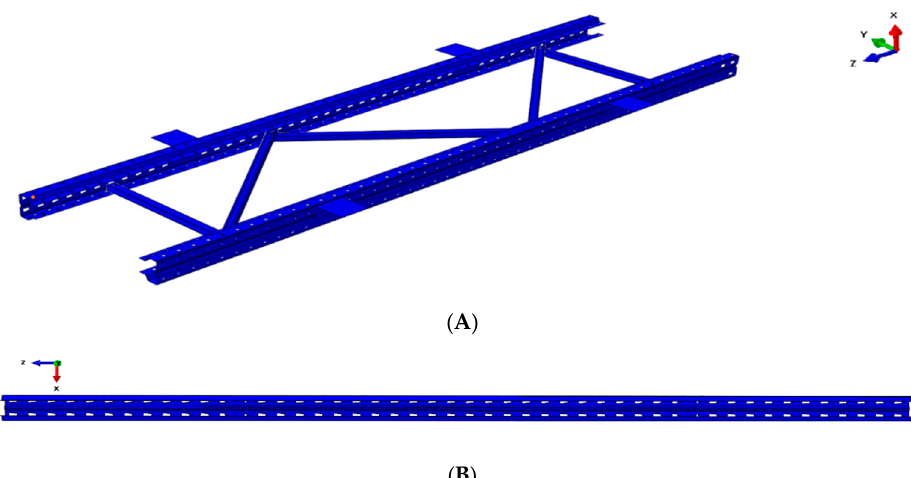
Figure 22. The finite element model arrangement: ( A ) major axis; ( B ) minor axis.